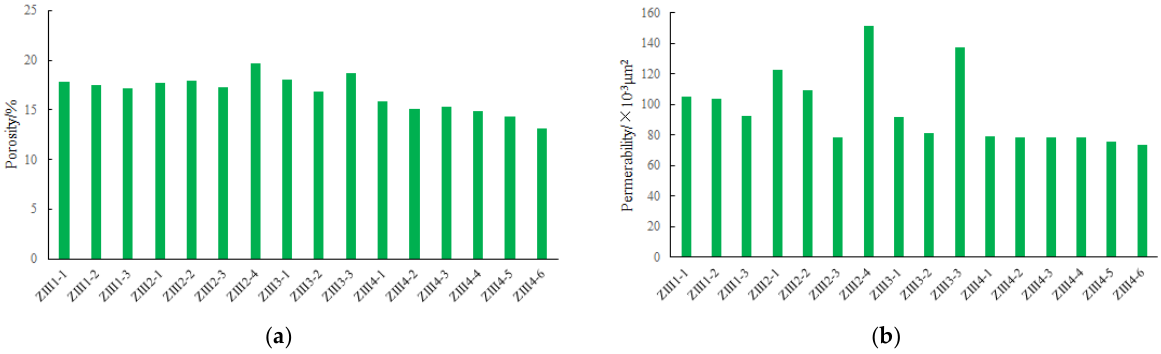
Figure 5. Reservoir properties of sub-sublayers of Z Ⅲ in the Wang Guantun Area. ( a ) porosity; ( b ) permeability.